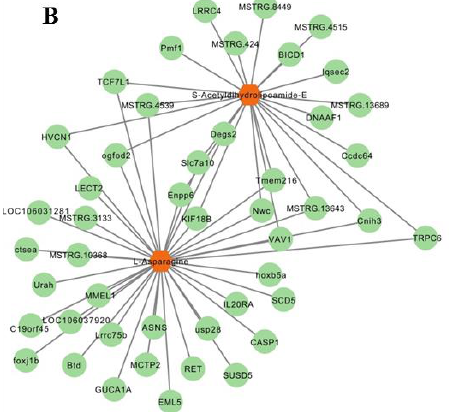
Figure 7. Integrated enrichment analysis of metabolites and DEGs. ( A ) Heatmap of all DEMs and DEGs. Gene names were described in italics and metabolites names in normal font. * indicates p < 0.05, ** p < 0.01,*** p < 0.001. ( B ) The DEGs related to s-acetyldihydrolipoamide-E and L-asparagine. Metabolites are in orange hexagon. Each green circle represents a gene.